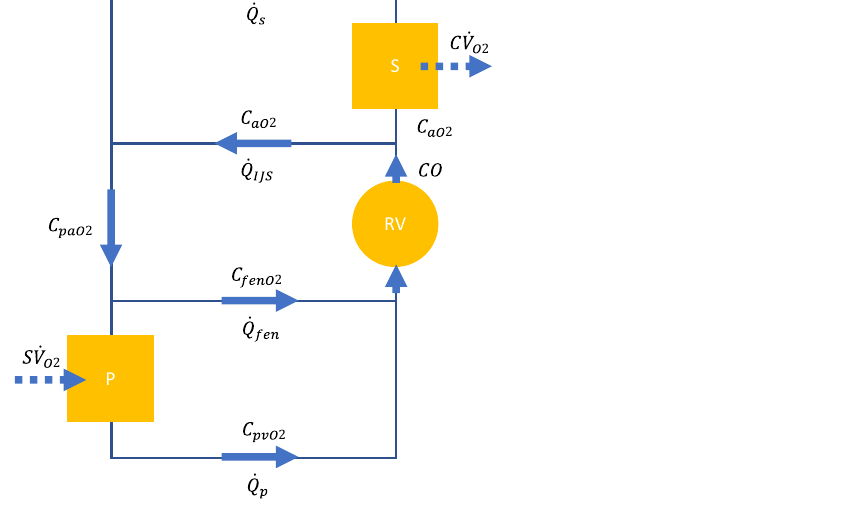
Figure 2. Generic oxygen transport model schematic ( CO = cardiacoutput [mL/min], Q ijs = IJSflow [mL/min], Q fen = fenestrationflow [mL/min], Q s = systemicflow [mL/min], Q p = pulmonaryflow ˙ V [mL/min ] , C O2 = 9 · m [mL/min] oxygen consumption/uptake with m = patientweight [ kg ] , C xxO2 = oxygenconcentration for a arterial, sv systemic venous, pa pulmonary arterial, pv pulmonary venous, S systemic circulation, and P pulmonary